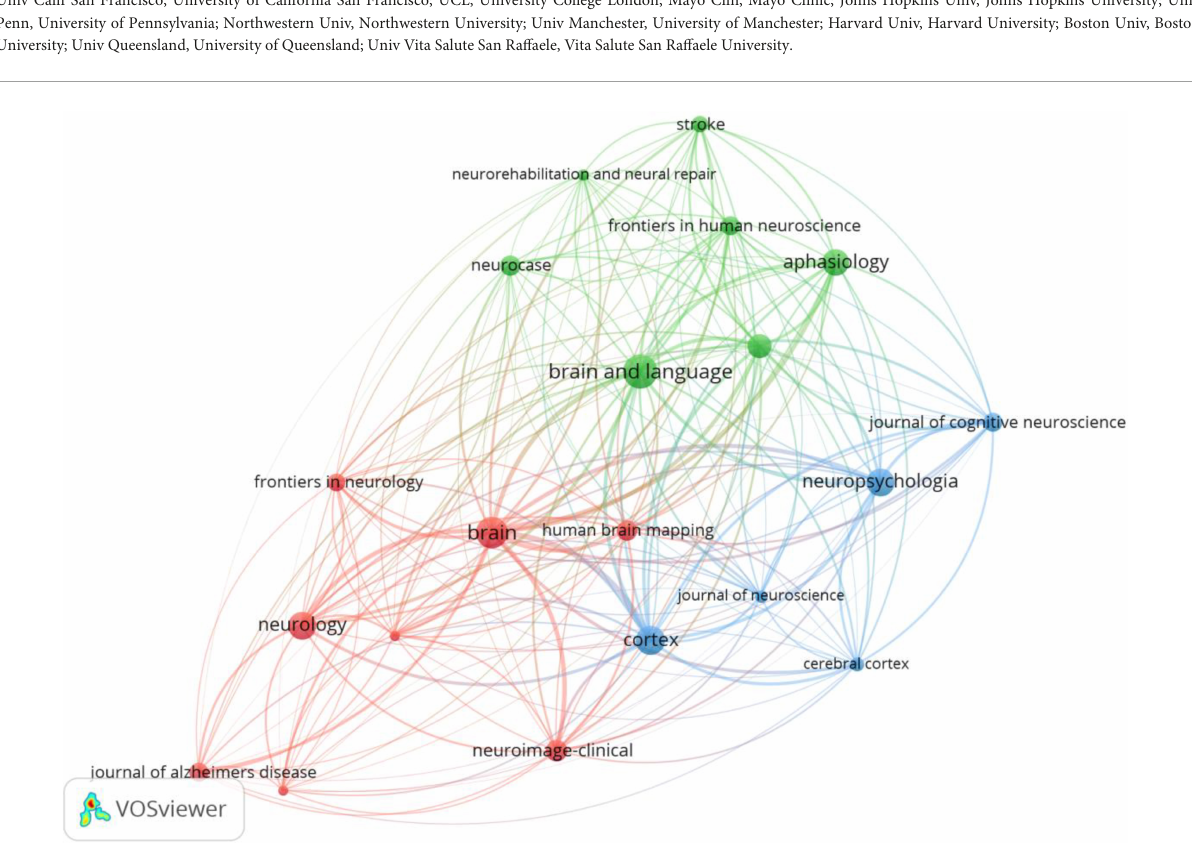
(0.07), Harvard University (0.07) and University of Toronto (0.07). The results show that American research institutions have carried out continuous and in-depth research in the